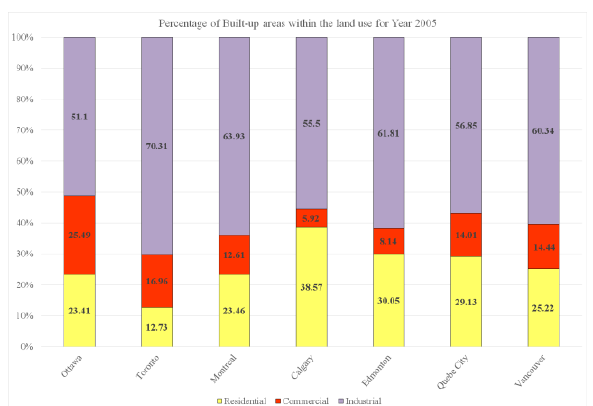
Figure 3. Percentage of built-up areas within the land use for 2005